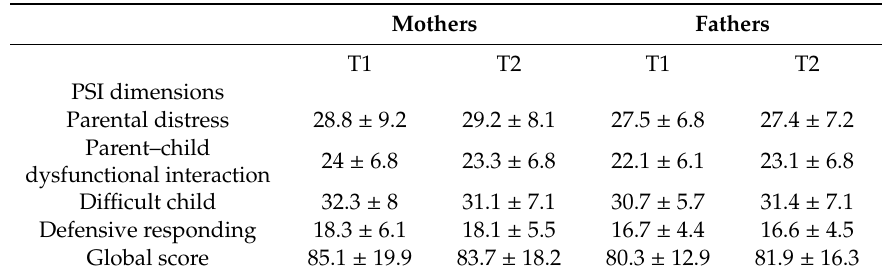
Table 2. Means ± Standard Deviations of the PSI dimensions and global score for mothers and fathers at T1 and